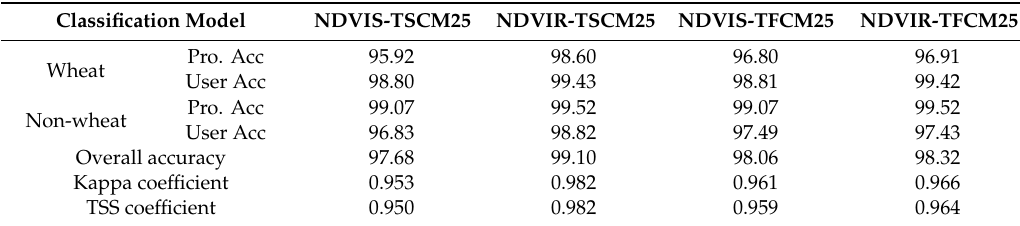
Table 4. Confusion matrix for the classification results using NDVI-TSCM25 and NDVI-TFCM25 under the SVM and RF classifiers (%).